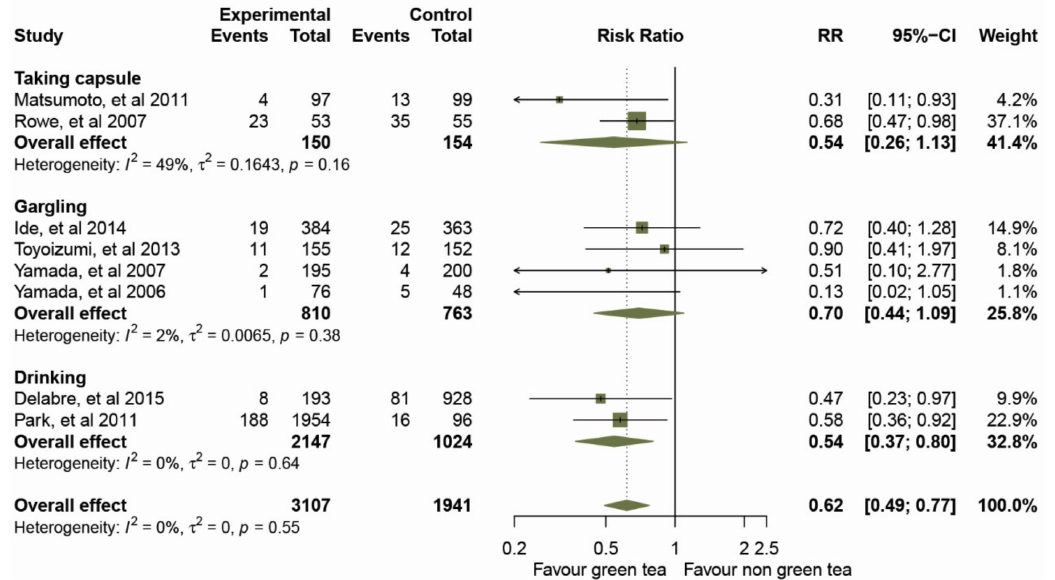
Figure 4. Effect of green tea on preventing influenza virus infection determined by route of